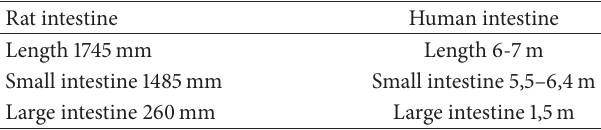
Table 4: Morphological comparison of the rat and human intestine. Rat intestine